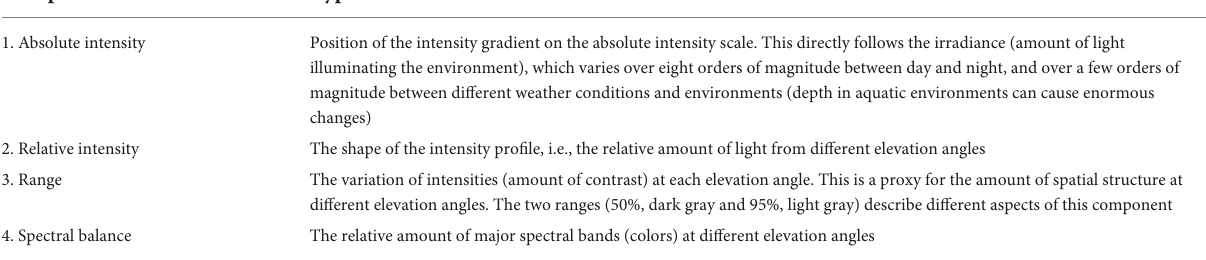
TABLE 1 Four components of the vertical light gradient identified in this investigation.